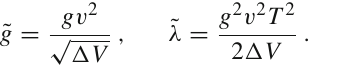
Fig. 5 Collision of two bubbles with values of (cid:10)ϕ and ˜ g indicated above the plots, and ˜ λ = 0 . 04. For the (cid:10)ϕ = 0 case the value of ˜ g is irrelevant. The solid and dashed curves correspond to | φ (cid:14) | = 0 . 1 and